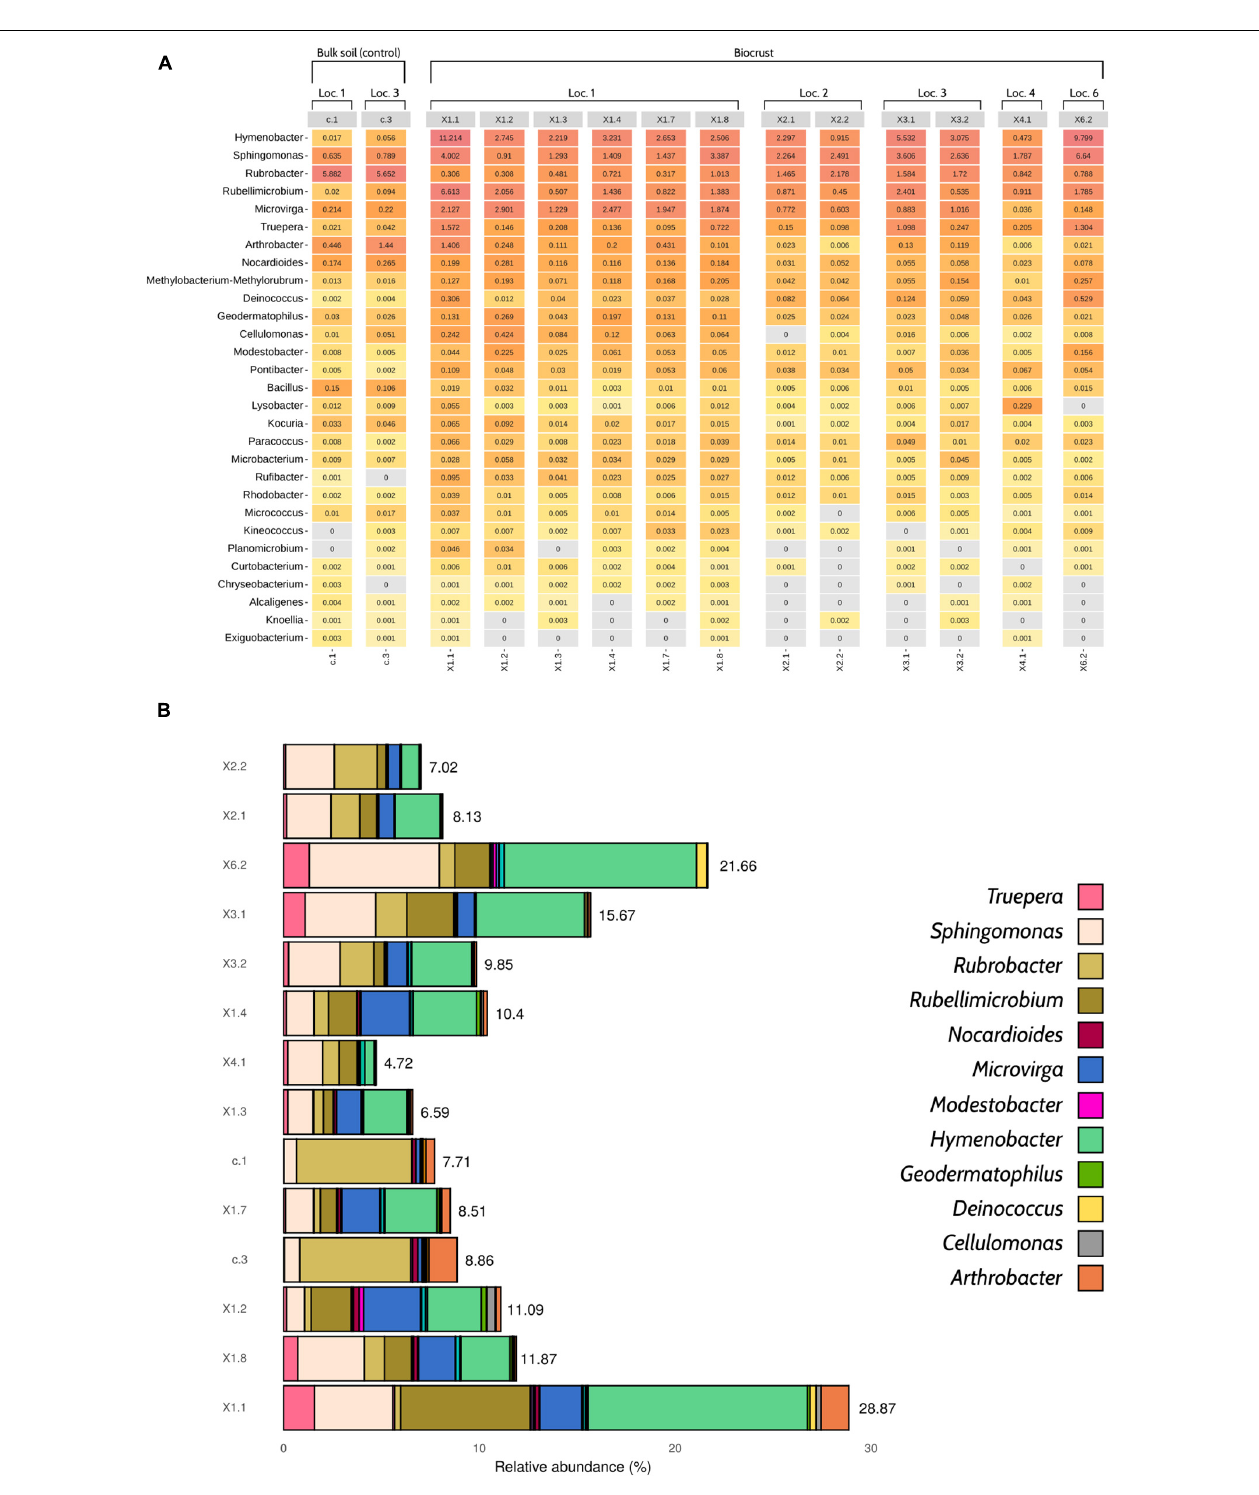
FIGURE 3 | Profile of desiccation- and radiation-resistant bacteria according to Nanopore sequencing data. (A) Heatmap showing the 29 genera of interest and their relative abundances (%). (B) Barplot displaying the cumulative relative abundances of the selected taxa ( n = 29). Only 12 genera have been colored in order to improve visualization, as the abundance of some taxa was so low that they cannot be properly distinguished in the figure. An interactive version of this figure including the 29 genera of interest can be found in Supplementary Figure 4 . The relative abundance of desiccation- and radiation-resistant genera was calculated considering the whole microbial community, not only the taxa of interest. Loc,